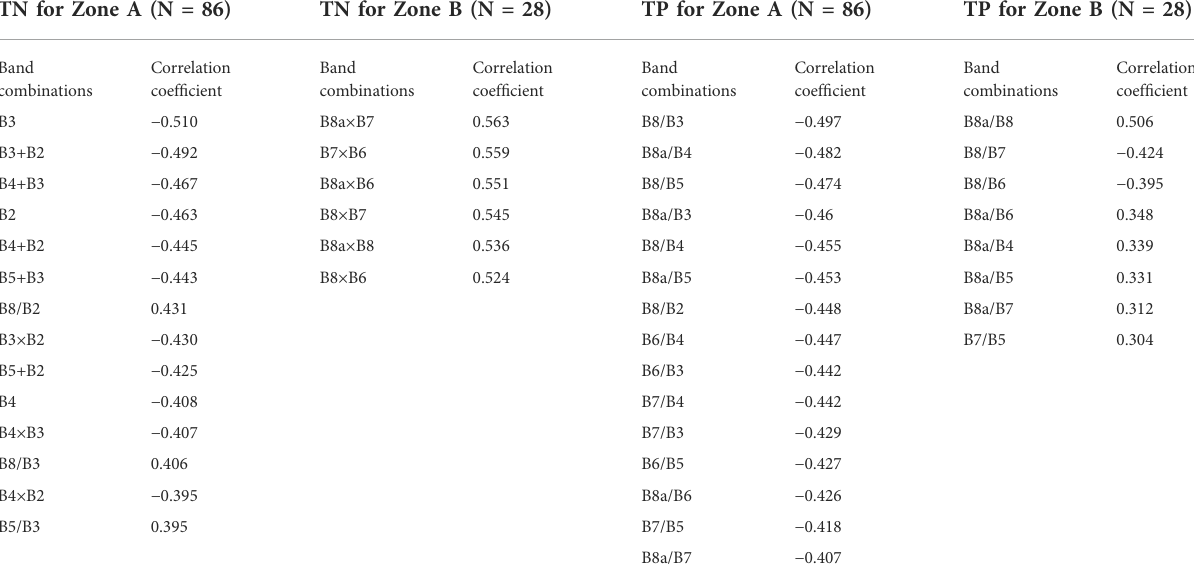
TABLE 1 Band combinations as the input variables for the TN/TP-retrieved models. TN for Zone A (N =